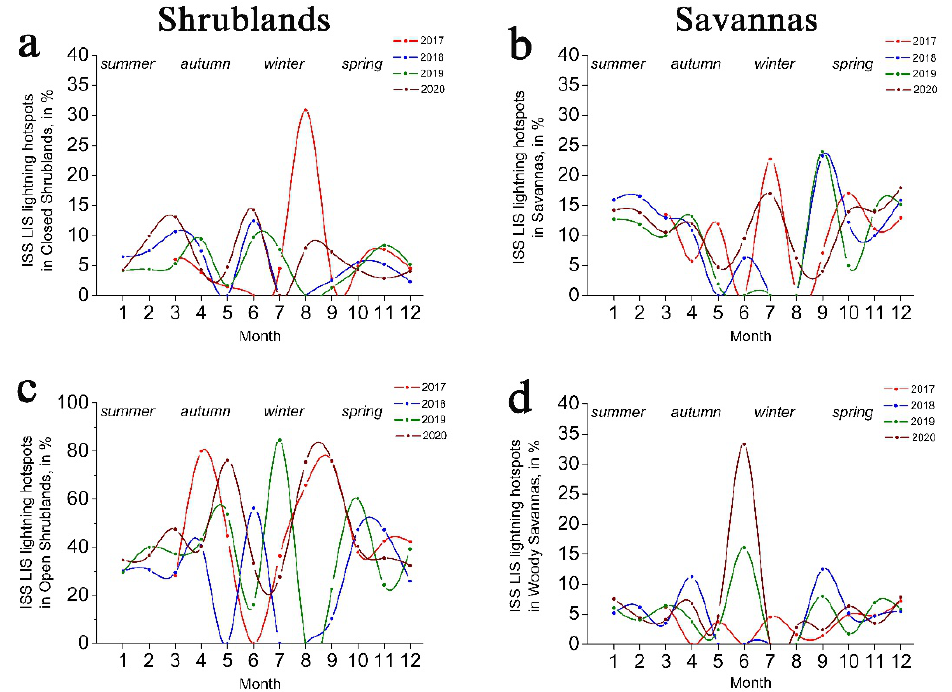
Figure 7. The monthly distributions of LISS ISS flashes, recorded in the open ( c ) and closed ( a ) shrublands, and in the woody ( d ) and grasslands savannas ( b ) as % of total monthly lightning flashes recorded in Australia in 2017–2020.